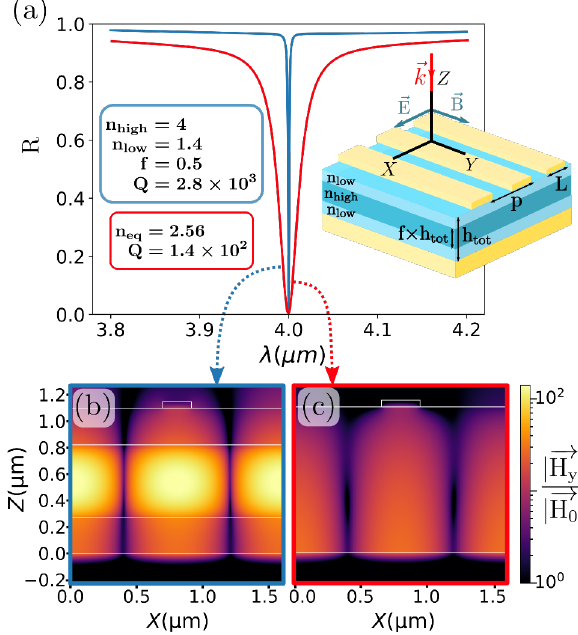
Figure 1. (a) General design of the structure in shown on insert. For both curves period p is set to 1 . 6 µ m and dielectric height h tot to 1 . 1 µ m. Blue and red curves respectively correspond to the responses of three- and one-dielectric design under TM normal illumination. For theses two architectures, the width of gold rib- bon is respectively set to 220 and 290nm. (b) and (c) present the enhancement of magnetic field at the resonance (4 µ m) for both structures. The maximal values are respectively 140 and